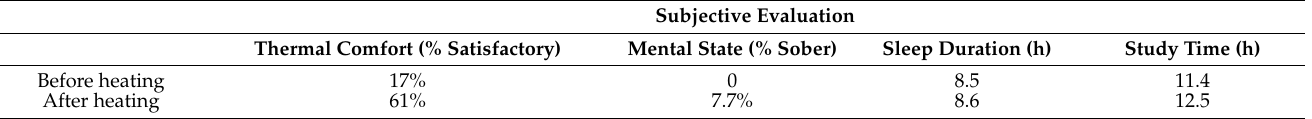
Table 6. The positive impact of IAQ.